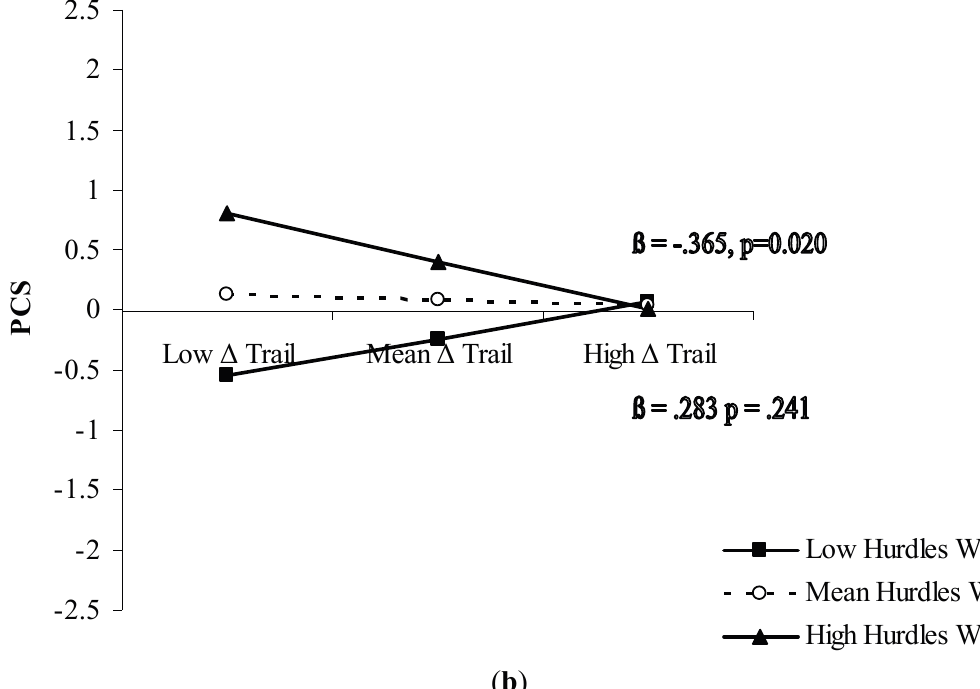
Figure 1. ( a ) Prediction of MCS accrued by inhibition capacity and moderated by walking speed while talking; and ( b ) prediction of PCS accrued by mental flexibility (good mental flexibility = low Δ Trail) and moderated by walking speed while negotiating hurdles. Solid lines: change in the slope of the predictor for high vs. low levels (1 sd change) of the respective moderator; value of ( β ) and its significance are reported. (WS = walking